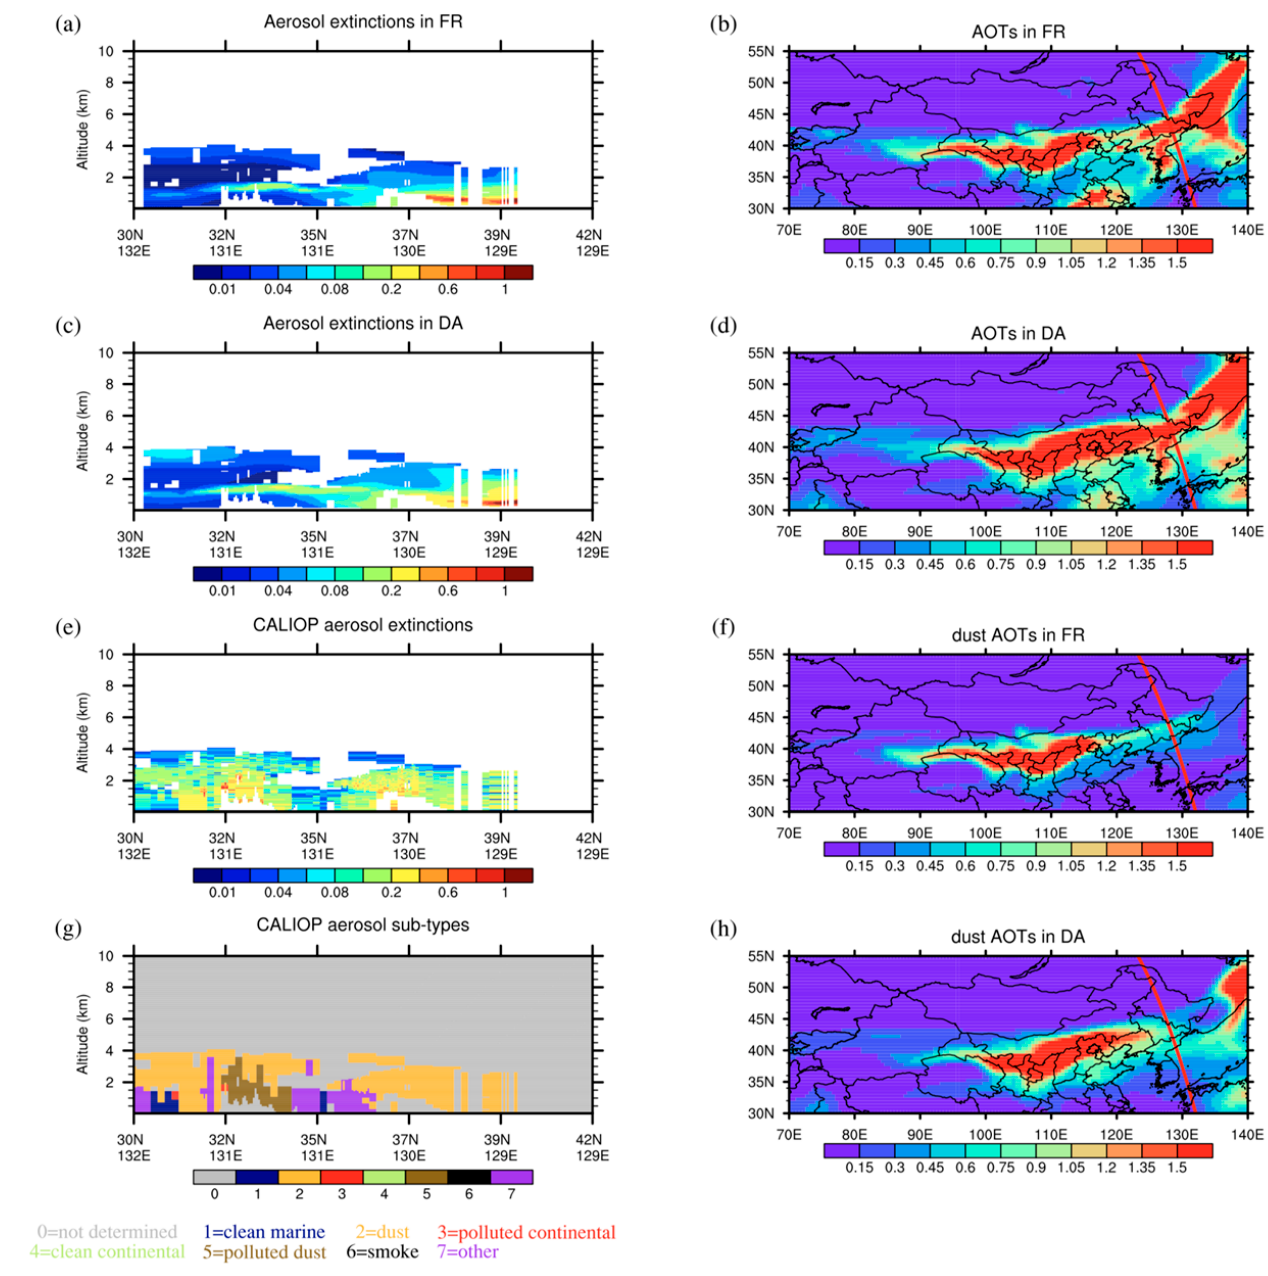
Figure 11. Profiles of simulated aerosol extinction coefficients at 550 nm (km − 1 ) in ( a ) FR and ( c ) DA experiments and CALIOP-observed ones at ( e ) 532 nm over the CALIPSO orbit path (indicated by red curve) at 04:06:03 (UTC) on 2 April 2018. Spatial distributions of ( b , d ) simulated total AOTs and ( f , h ) dust AOTs for the two experiments. ( g ) CALIPSO-detected vertical aerosol